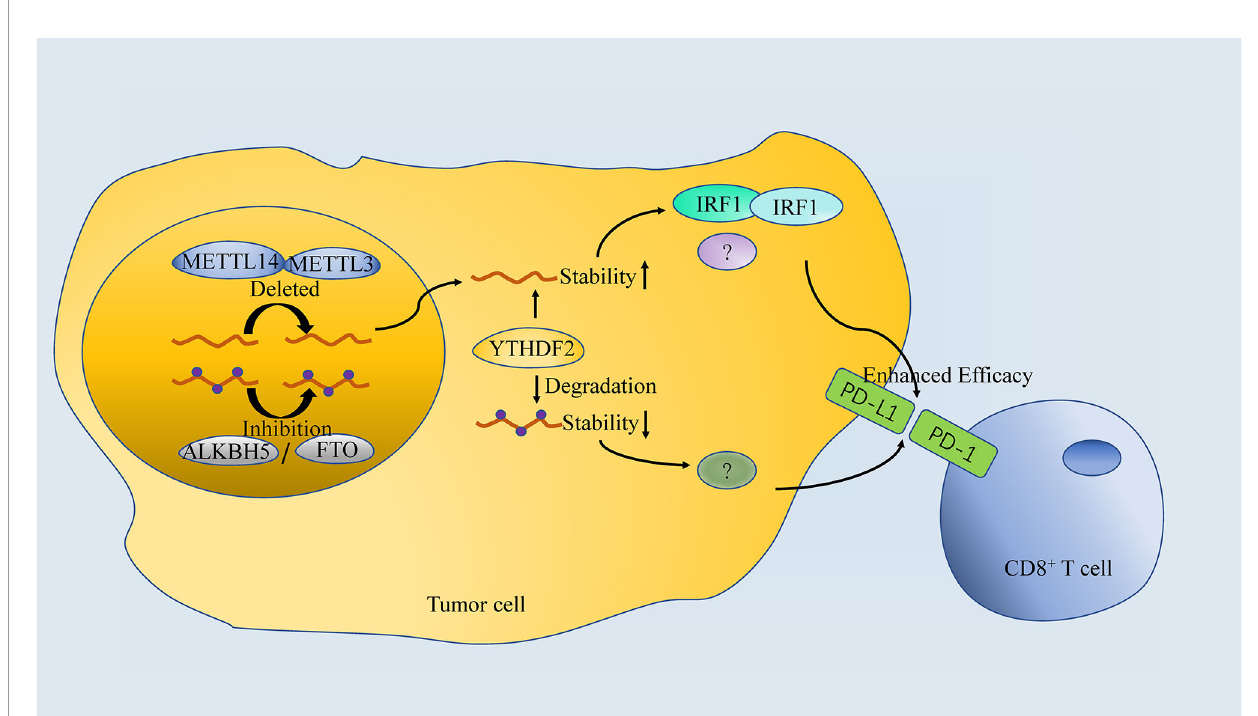
FIGURE 4 | The association between m 6 A regulator and anti-PD-1 treatment. Both Inhibition or Deletion of “ writers ” or “ erasers ” enhances the ef fi cacy of anti-PD-1 therapy, which is done by targeting speci fi c RNA in a YTHDF2-dependant